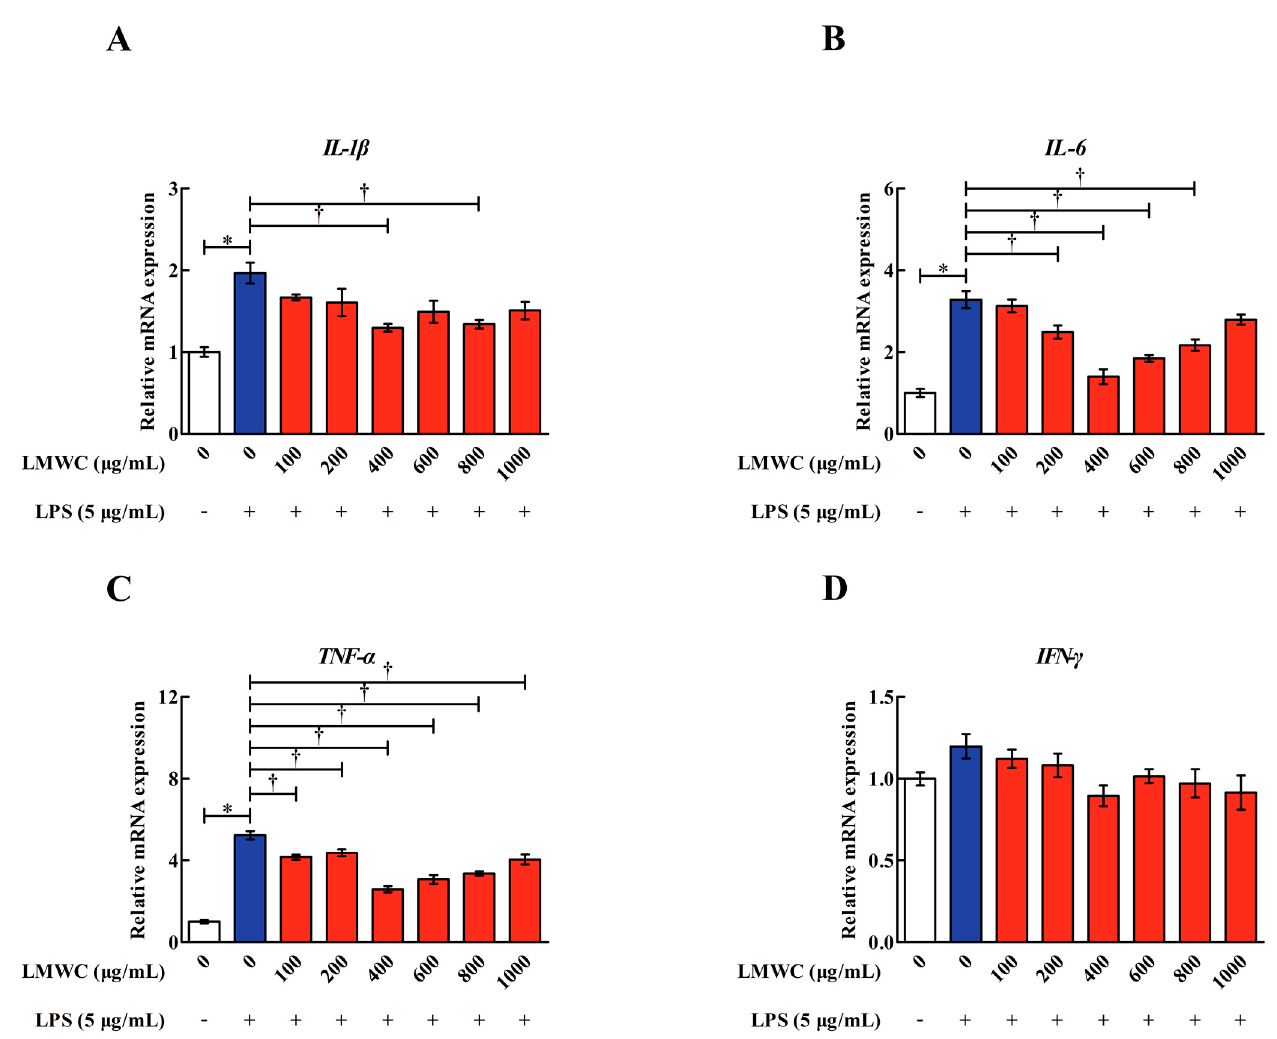
Figure 2. Relative IL-1 β , IL-6 , TNF- α and IFN- γ mRNA levels in LPS-treated IPEC-J2 cells after pretreatment with different concentrations of LMWC. ( A ) IL-1 β : interleukin-1 β . ( B ) IL-6 : interleukin-6. ( C ) TNF- α : tumour necrosis factor- α . ( D ) IFN- γ : interferon- γ . Cells were pretreated with various concentrations of LMWC (0, 100, 200, 400, 600, 800 and 1000 μ g/mL) for 2 h, followed by cotreatment with LPS (5 μ g/mL) for another 6 h. Data are presented as the mean ± standard error ( n = 4). * Means significant difference compared with the control group ( p < 0.05). † Means significant difference compared with the LPS group ( p < 0.05).